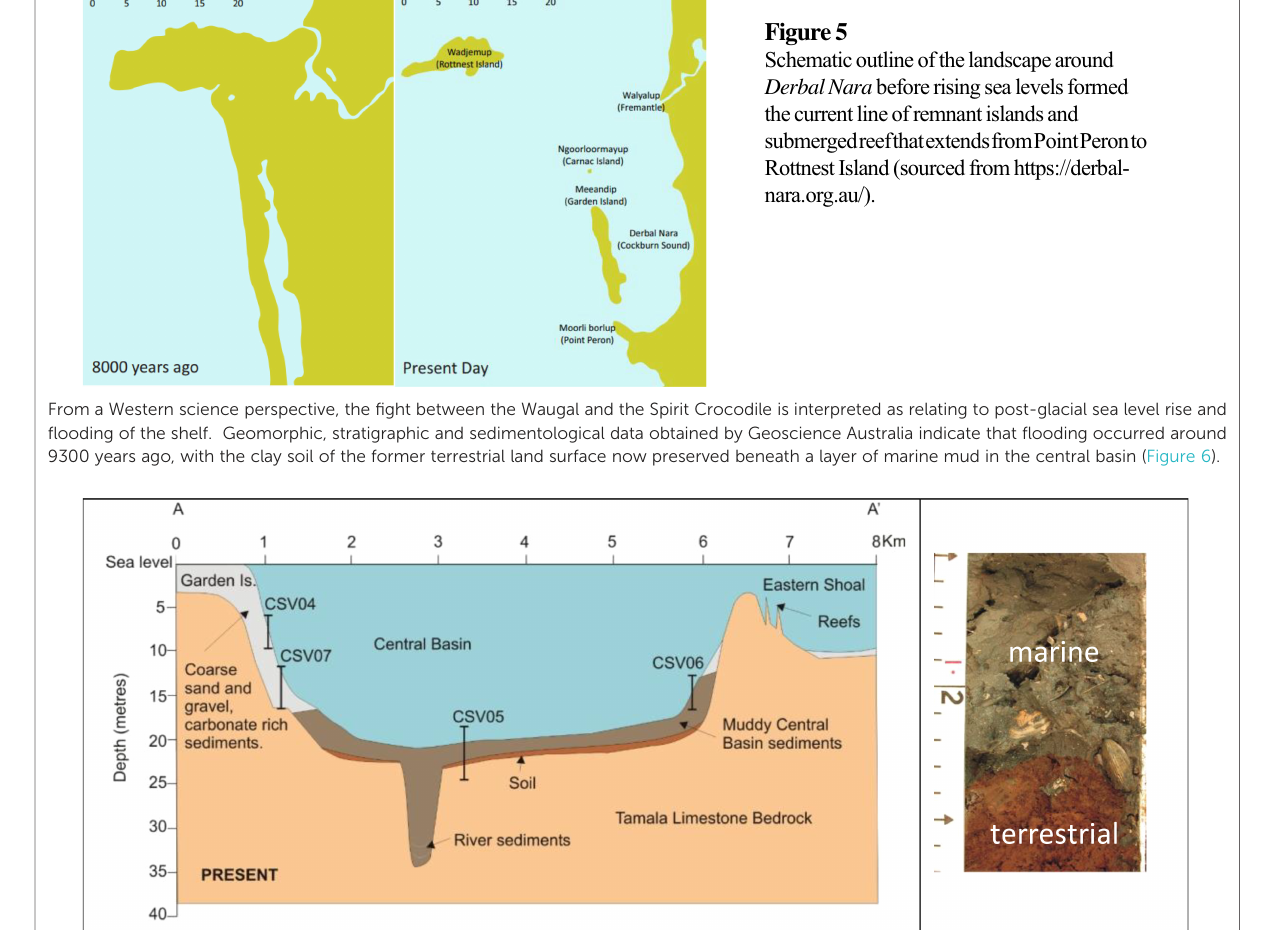
Figure 5 Schematicoutlineofthelandscapearound DerbalNara beforerisingsealevelsformed thecurrentlineofremnantislandsand submergedreefthatextendsfromPointPeronto RottnestIsland(sourcedfromhttps://derbal-